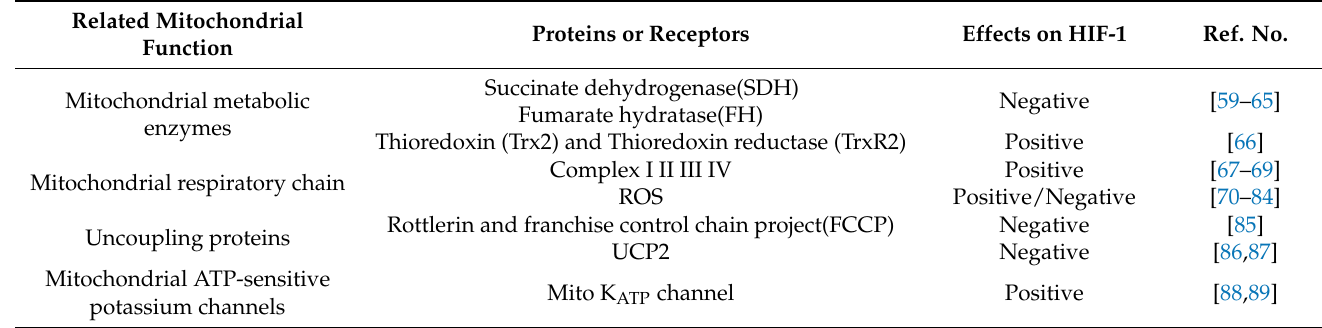
Table 1. The effect of mitochondria on HIF-1 activity or